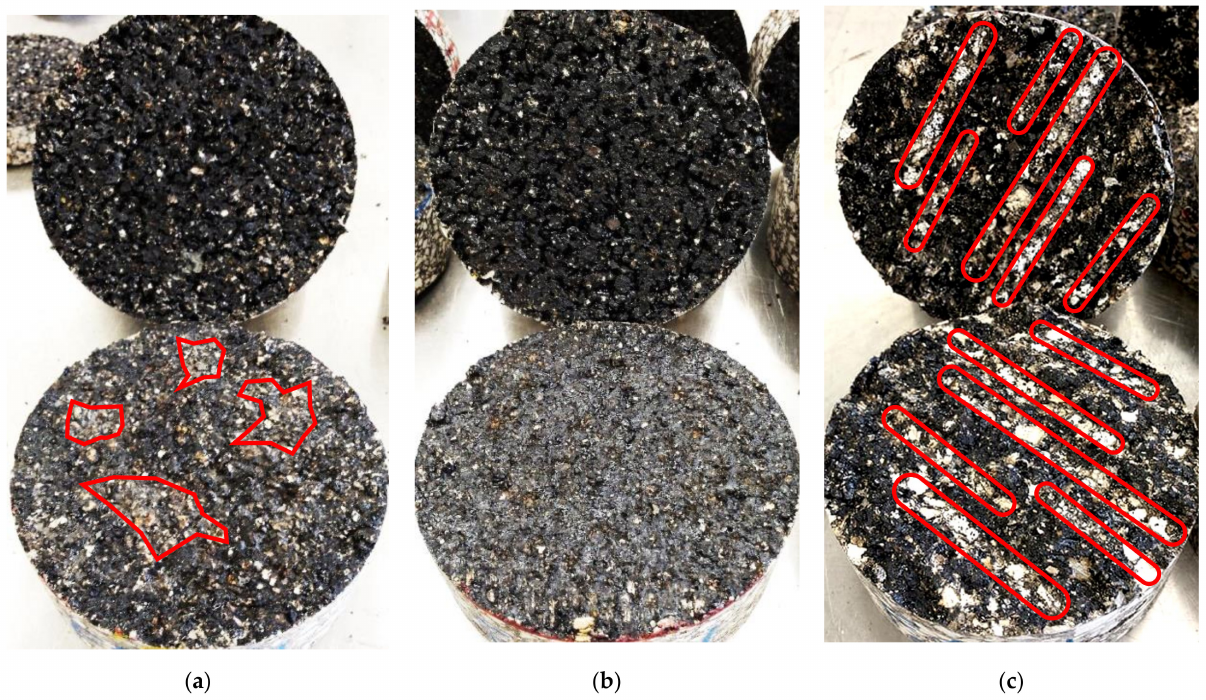
Figure 11. Interface shear failure of field cores having different underlying layers in: ( a ) existing, ( b ) new, and ( c ) milled sections. Note: red marked areas indicate adhesive failure between the tack coat and substrate surface.